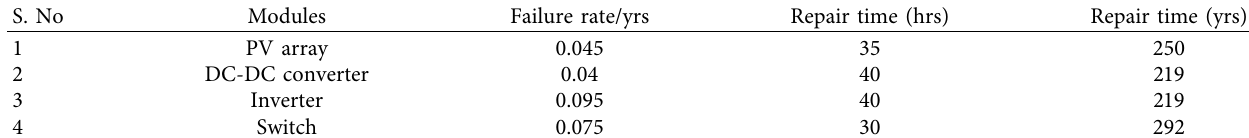
Table 4: Failure rate and repair times.